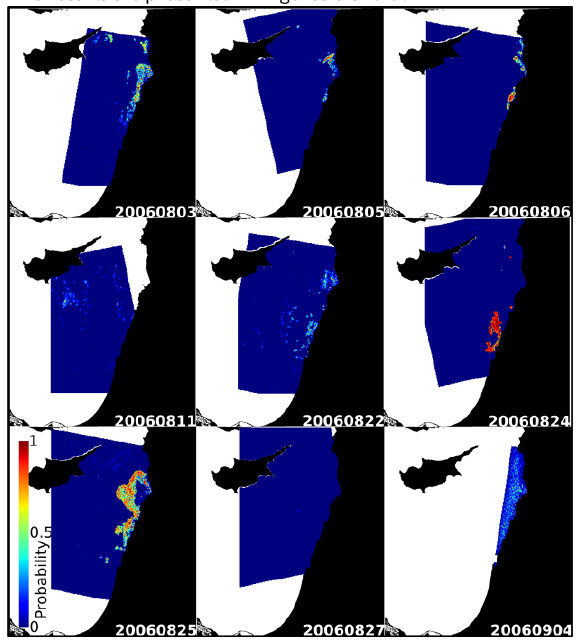
Figure 5. Results obtained from the automatic oil spill detection algorithm.